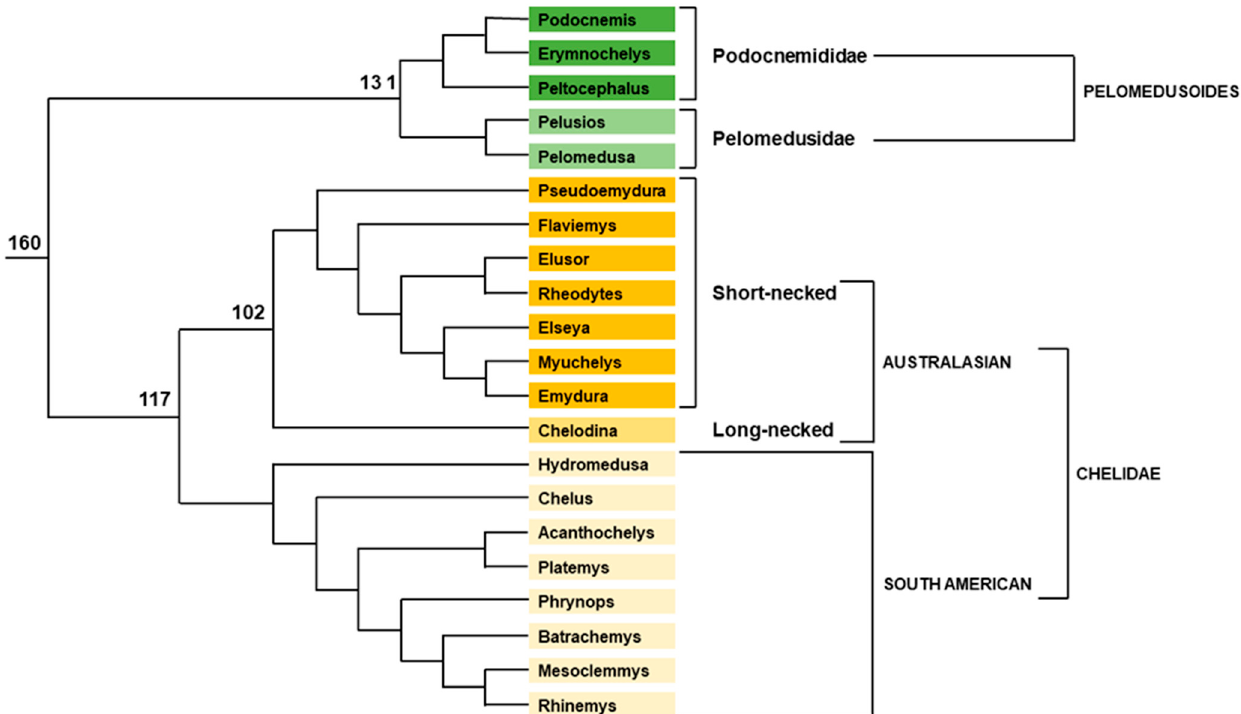
Figure 4. Phylogenic tree of pleurodiran turtles. Relative positions of each genus and superior clade are represented. Branch lengths are not proportional to time. Numbers indicate divergence time (Myrs) from present for some key nodes, according to [39]. Color of each genus indicates the different clades.